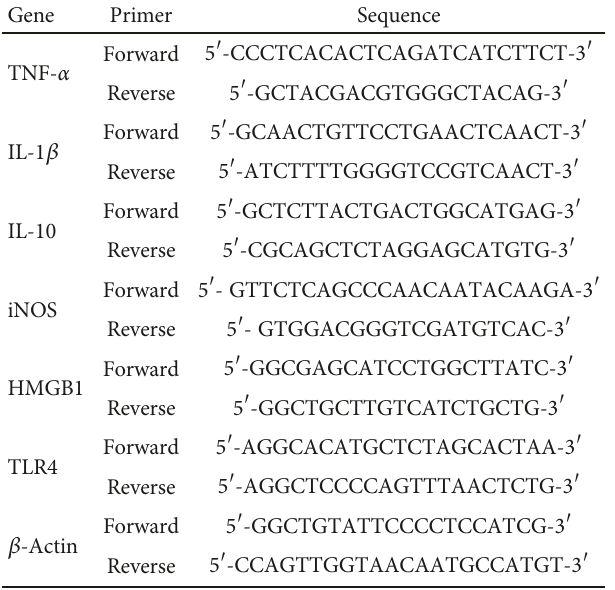
Table 1: Primers for quantitative polymerase chain